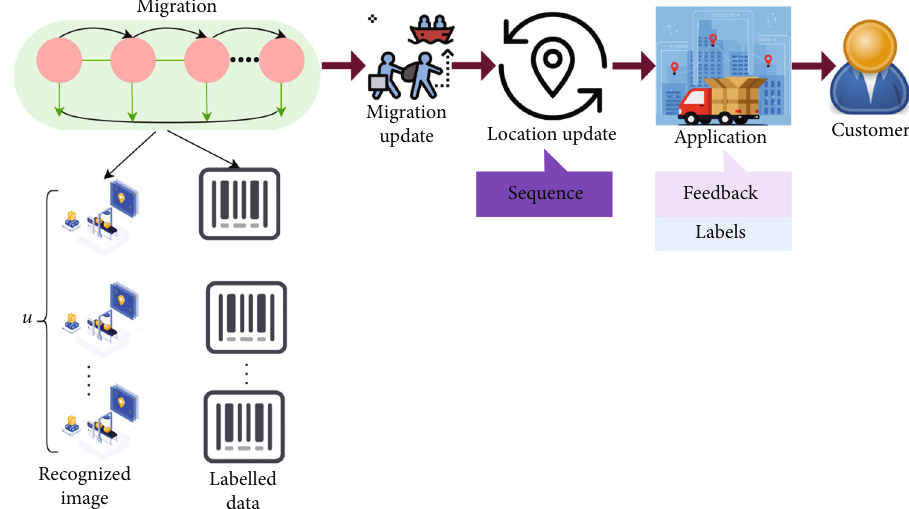
Figure 4: Tracking and update illustration.